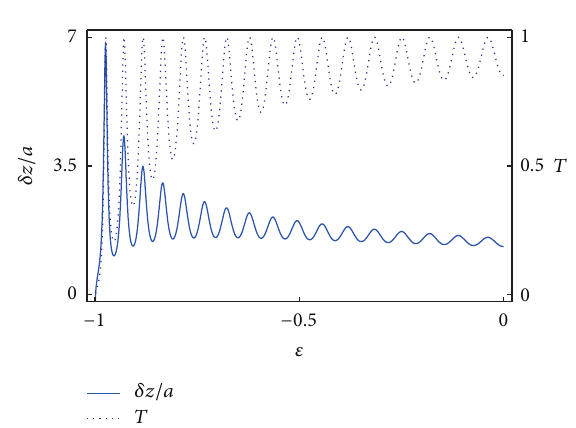
Figure 3: Longitudinal shift (continuous line) and transmission coefficient (dotted line) of an electric wave propagating in a dielectric slab of width 𝑘 0 𝑎 = 30 and constant refractive index = 1.5 , both as a function of the propagation constant 𝜀 . Observe 𝑈 0 that the maxima of both curves coincide.